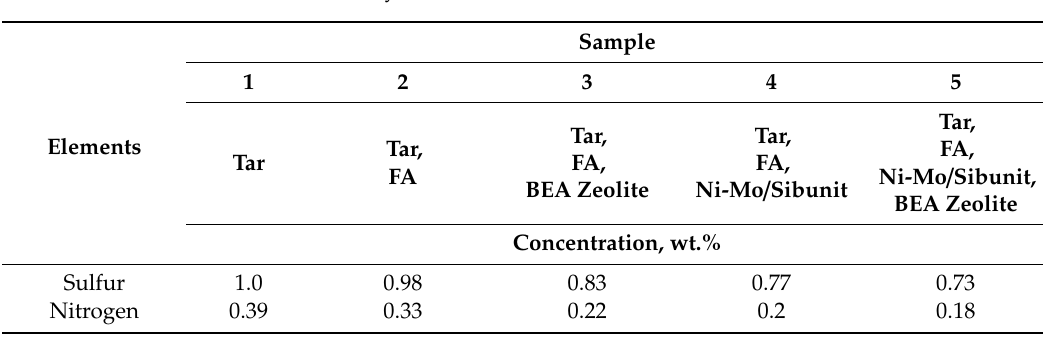
Table 10. Changes of the sulfur and nitrogen concentrations in liquid products depending on the addition of formic acid and the